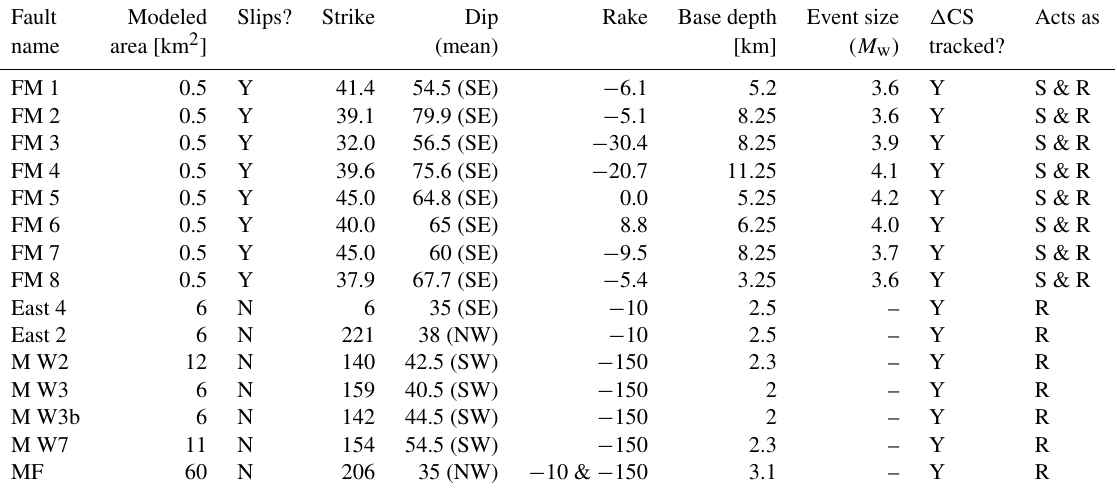
Table 2. Information for the geometrical fault model used in Coulomb 3.3. Both FM and mapped faults are described. Regarding the last two columns, (cid:49) CS are tracked on all faults and the FM faults act as both sources (slip) and receivers, whereas the mapped faults act only as the